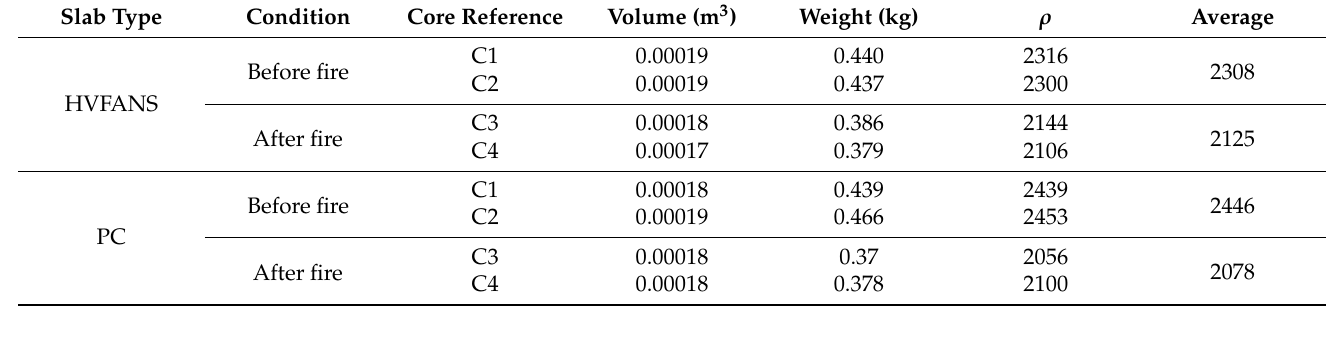
Table 5. Density ( 𝜌 ) (kg/m 3 ) of PC and HVFANS slabs before and after firing.